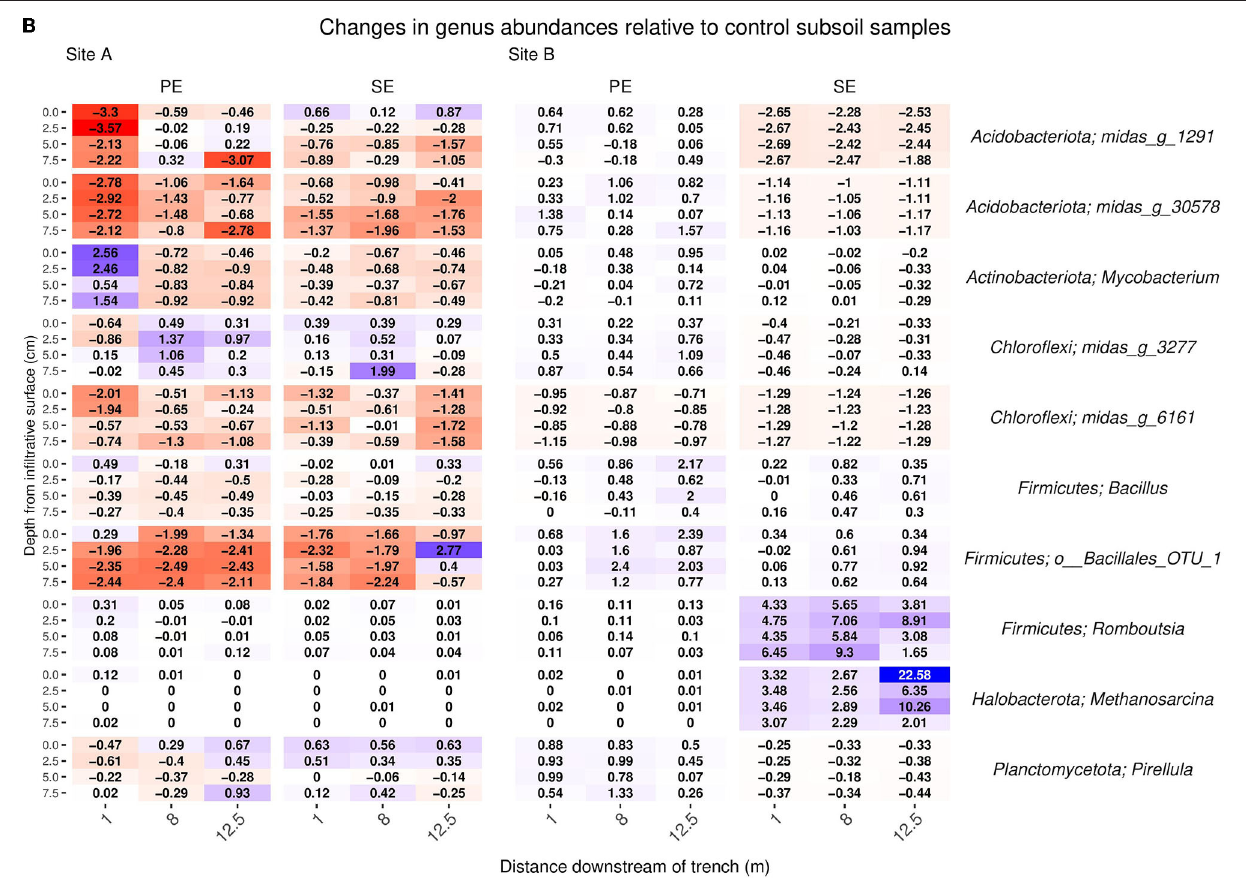
FIGURE 3 | (A) Mean ± SD of relative read abundance of genus-level analysis for Sites A and B for both the Primary (PE), secondary (SE), and control samples for each “system”: control; base (CB), top (CT), STU topsoil (TT), and STU subsoil “trench base” (TB). The STU base is further divided into proximal (P) at 1m, midpoint (m) at 5m, and distal (d) at 12m. (B) 2D spatial profile of changes of key genus relative abundance with respect to the control subsoil communities; increases are highlighted in blue and reductions in